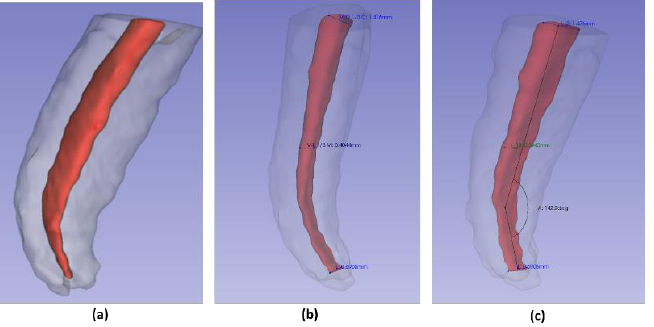
Figure 4. Segmentation and measurements: ( a ) root segmentation; ( b ) diameter measurement; ( c ) angle measurement.